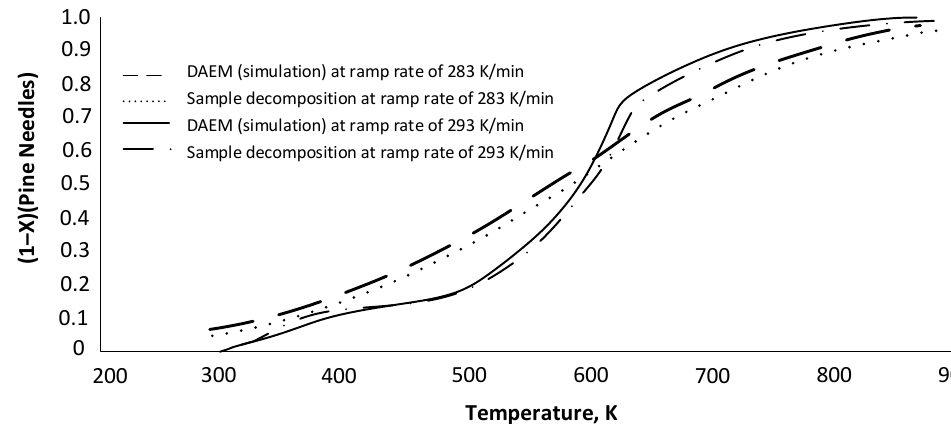
Fig. 5.Verification of optimized kinetic parameters applicability for different ramp rates: 283 K/min and 293 K/min. 𝑋 Calculated